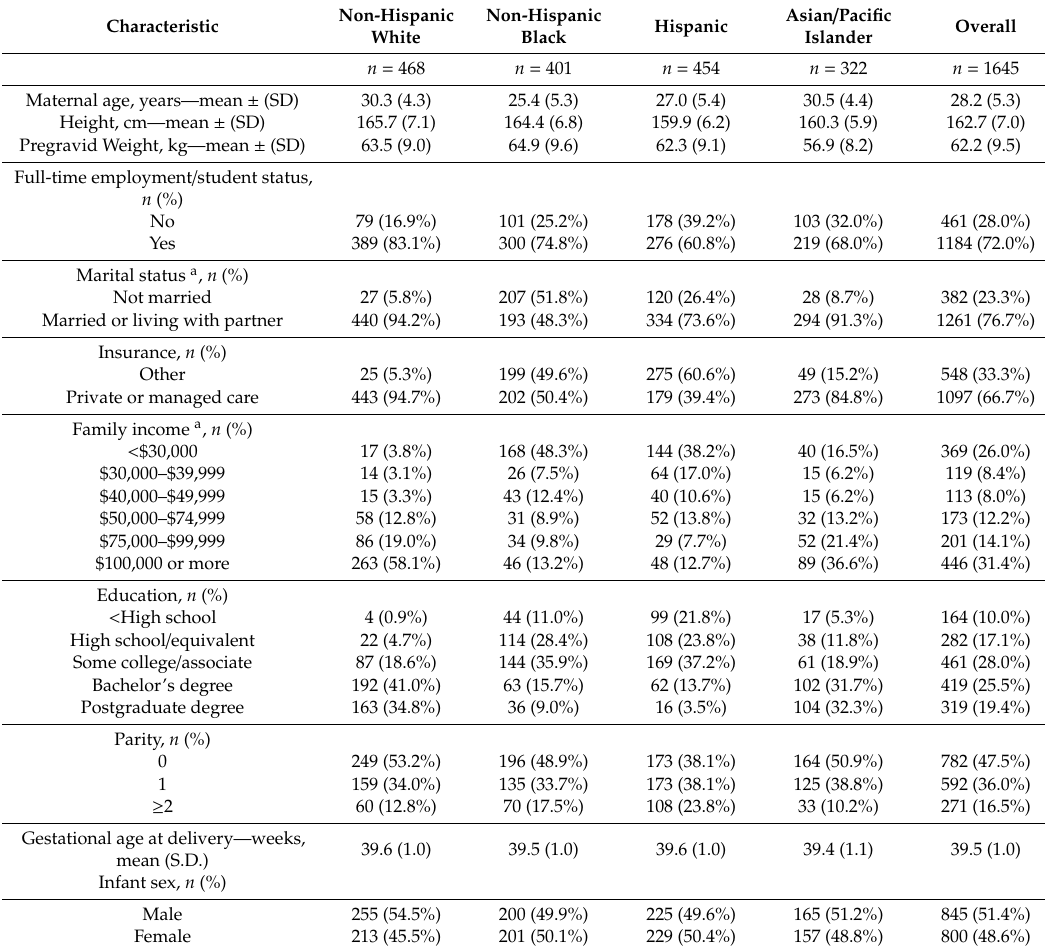
Table 1. Maternal and neonatal characteristics among self-reported racial / ethnic groups. Characteristic